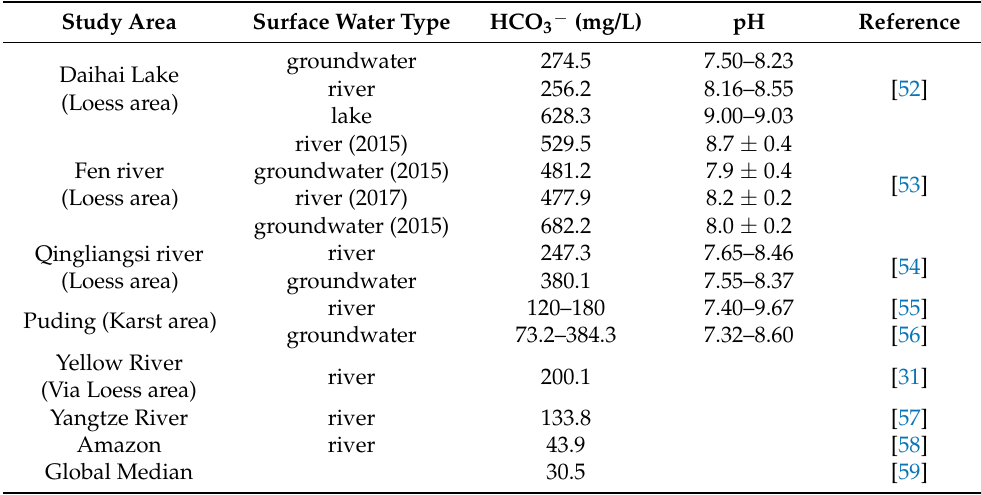
Table 1. Comparison of HCO 3- concentration and pH in surface water ecosystems in karst and loess areas, based on the results of this study and previous